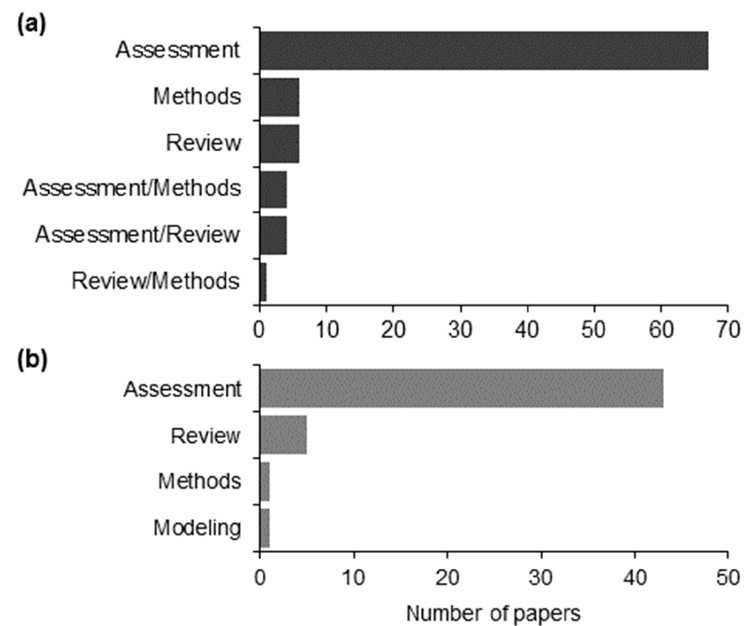
Figure 3. Approaches used in the papers addressing the use of ( a ) organic matter decomposition ( n = 88) or ( b ) ecosystem metabolism ( n = 50) as bioassessment tools of stream functional integrity (for the definitions, see Tables S1 and S2).